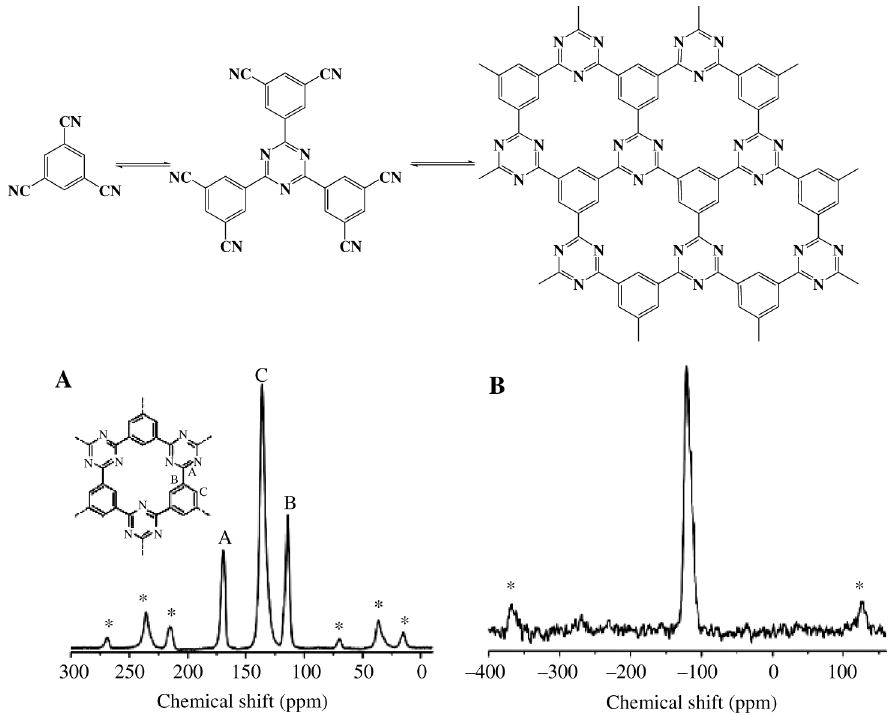
Figure 5: Trimerization of 1,3,5-tricyanobenzene. (A) 13 C CP-MAS solid-state NMR and (B) 15N CP-MAS solid-state NMR of